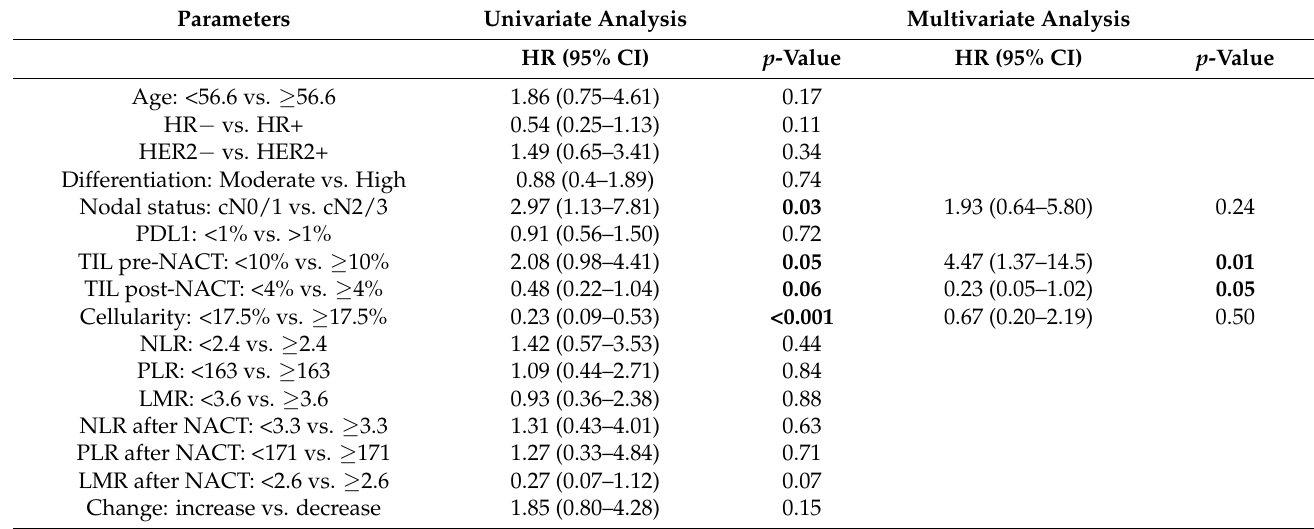
Table 6. Uni- and multivariate analysis for OS in the group of IBC patients without pCR after NACT. IBC: inflammatory breast cancer, HR: hormone receptor status, sTIL: stromal tumour infiltrating lymphocytes, NACT: neo-adjuvant chemother- apy, NLR: neutrophil-lymphocyte ratio, PLR: platelet-lymphocyte ratio and LMR: lymphocyte-monocyte ratio. Bold values